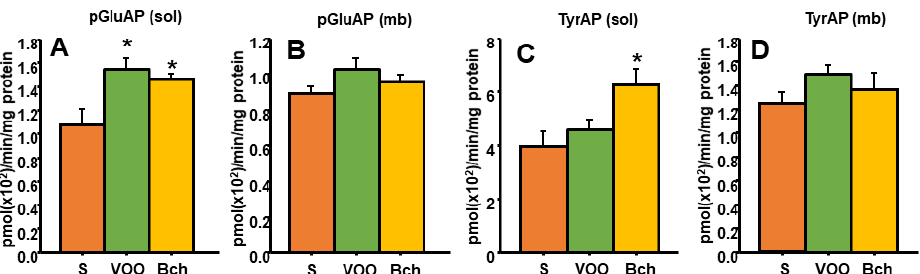
Figure 2. Means values ± standard errors of pyroglutamyl aminopeptidase activity (pGluAP) in liver-soluble ( A ) and membrane-bound ( B ) fractions, and tyrosine aminopeptidase activity (TyrAP) in liver-soluble ( C ) and membrane-bound ( D ) fractions, expressed as pmol/min/mg prot. S: standard diet, VOO: virgin olive oil diet, Bch: butter plus cholesterol diet. * indicates significant differences between VOO or Bch vs S. * p <0.05.